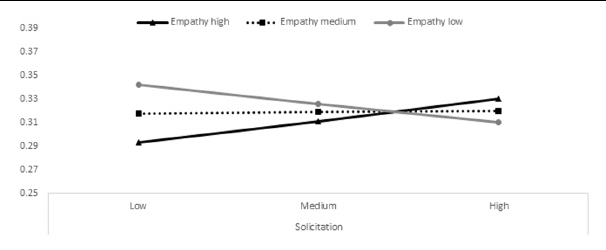
FIGURE 3 | Association between paternal solicitation at T1 (on the x -axis) with adolescent antisocial behaviors at T2 (on the y -axis) for low (gray line), medium (dashed line), and high (black line) levels of state perspective